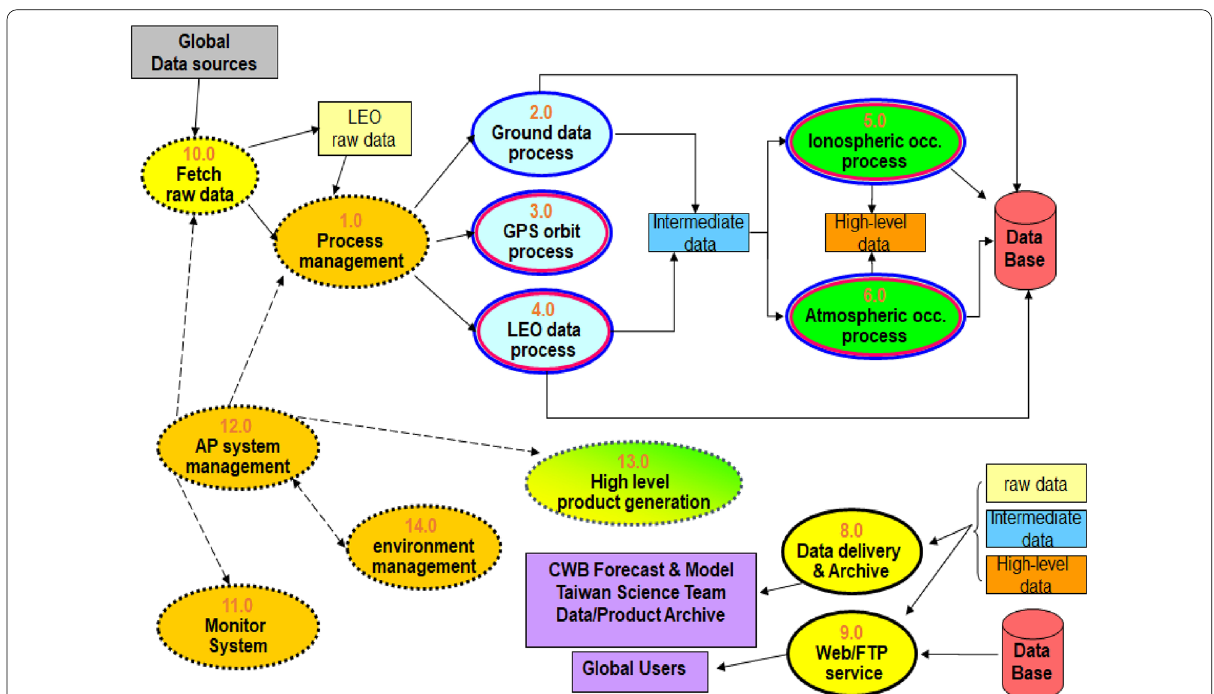
Fig. 1 Architecture of TROPS. The left side, upper right side, and lower left side show the sections for data collection, data processing, and data service, respectively. In the data processing portion, the blue oval indicates the POD module and the green ovals are the modules for atmospheric and ionospheric data retrieval